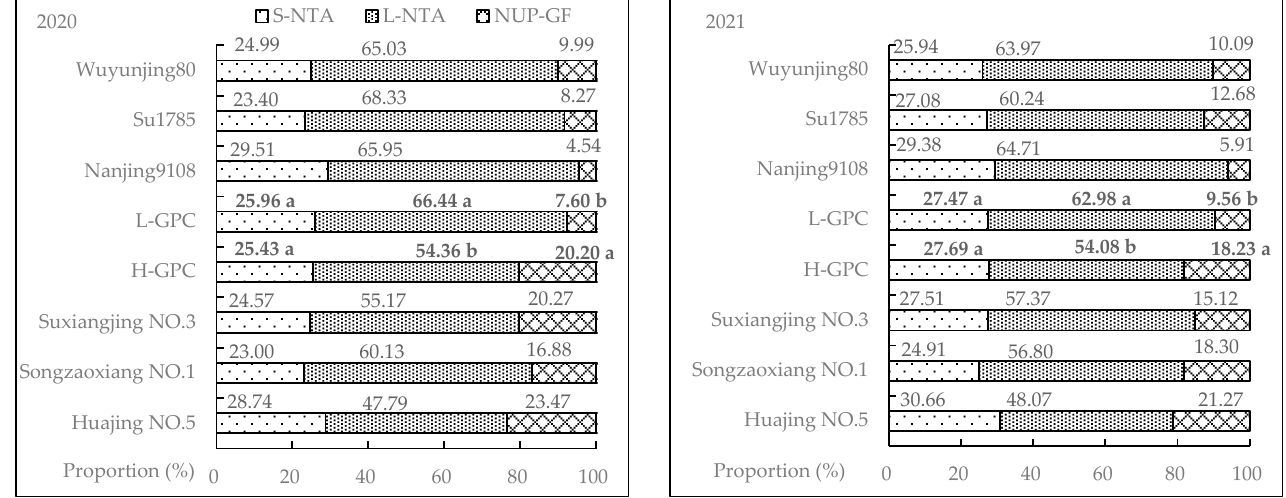
Figure 2. The proportions of S ‐ NTA, L ‐ NTA and NUP ‐ GF in NIA ‐ P. S ‐ NTA, stem nitrogen translocation amount; L ‐ NTA, leaf nitrogen translocation amount; NUP ‐ GF, nitrogen uptake during grain ‐ filling period; NIA ‐ P, nitrogen increase in panicle during grain ‐ filling period. Different lowercase letters after values indicate a significant difference at the 0.05 probability level.